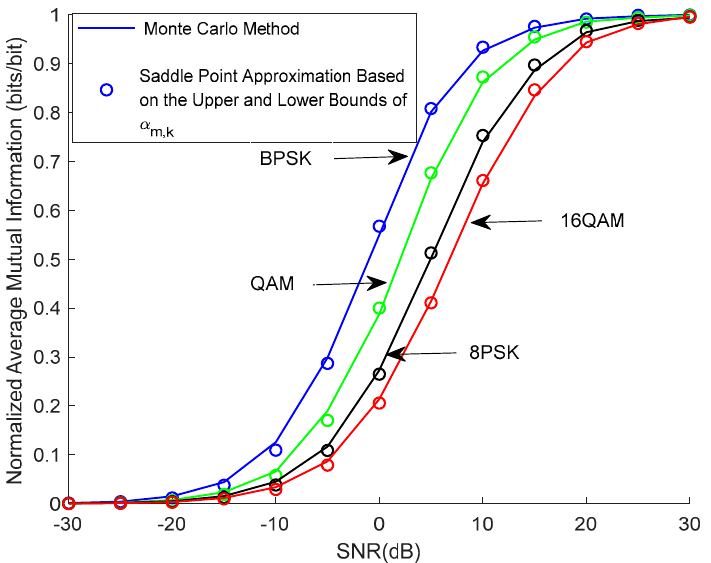
Figure 3. Comparison on normalized MI calculated by Monte Carlo and saddle point approximation according to upper and lower bounds of α m , k by (14) under different input types, correction parameters ( ρ T = ρ R = ρ = 0.5) over doubly correlated Rayleigh fading channel model (N T = N R = 2). Comparison of MI calculated by Monte Carlo and the lower bound of saddle point approximation methods by (15) over doubly correlated Rayleigh fading channel are shown in Figure 4. With the increase in SNR, the mutual information increased, and the accuracy of saddle point approximation became higher. It was also clear that the lower bound of saddle point approximation achieved considerable accuracy for different doubly correlated MIMO fading channel scenarios.